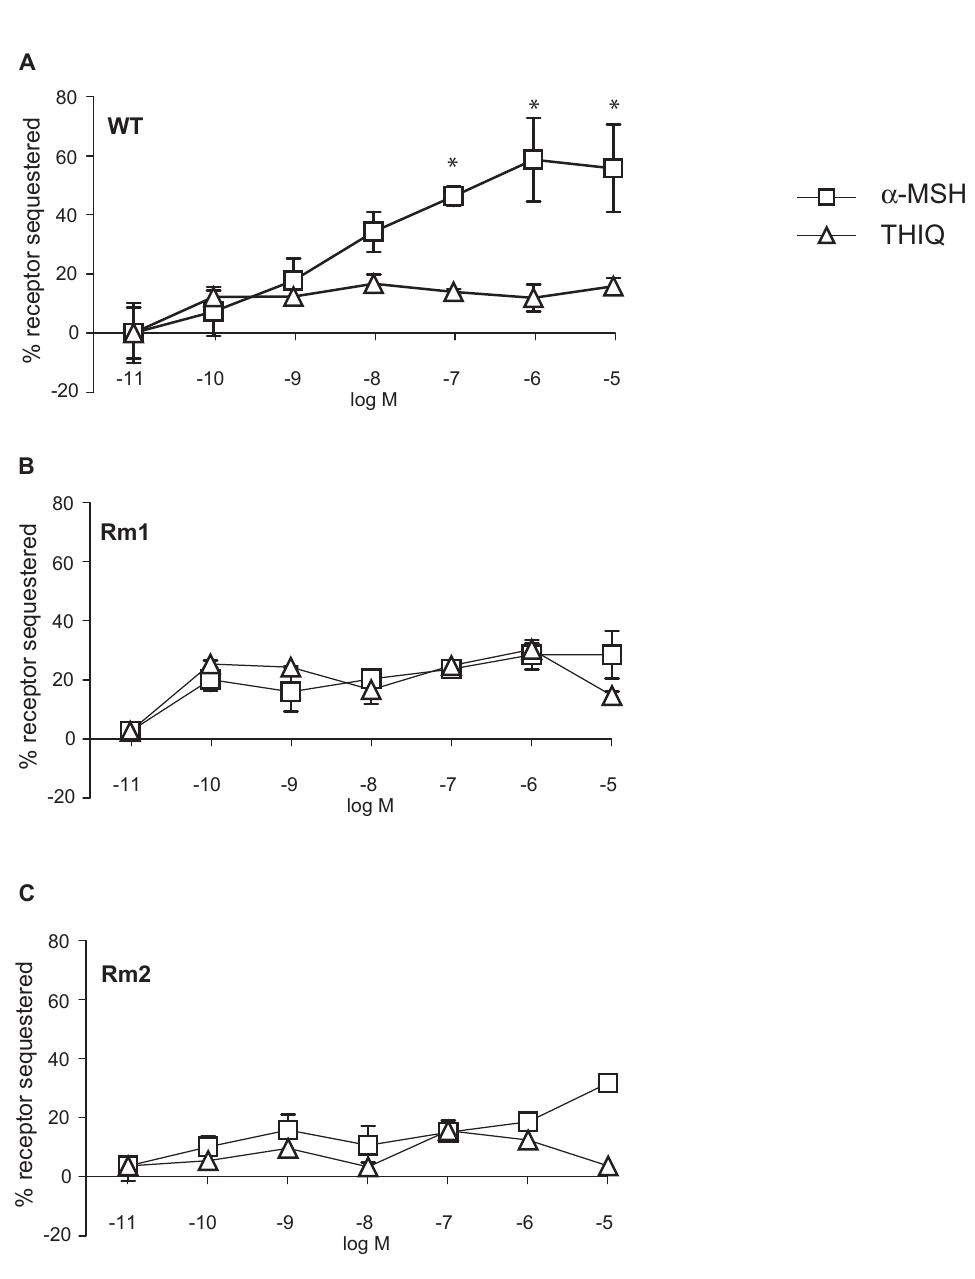
Figure 6. HEK293 cells stably expressing wild-type MC4R (A), Rm1 (L106P) (B),and Rm2 (D122A) (C)were exposed to increasing concentrations of a -MSH or THIQ for 2 h. Cell-surface FLAG-tagged receptors were measured by ELISA. Receptor sequestration was calculated as the loss of receptor expression from the cell surface. Wild-type MC4R was internalized significantly more ( p , 0.05) in response to a -MSH than THIQ at doses of 10 2 7 M and higher. Data represent the mean 6 s.e.m. of two independent experiments, each performed in